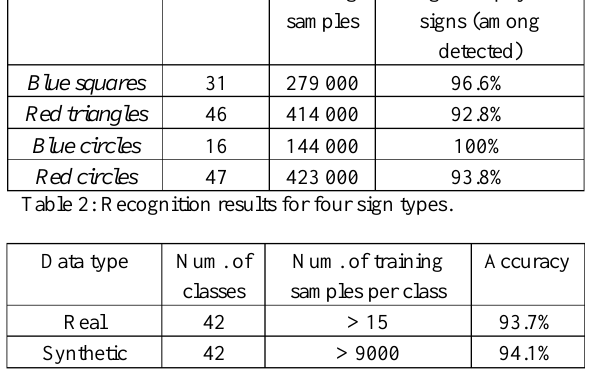
Table 3: Comparison of recognizer’s trained on real and synthetically generated